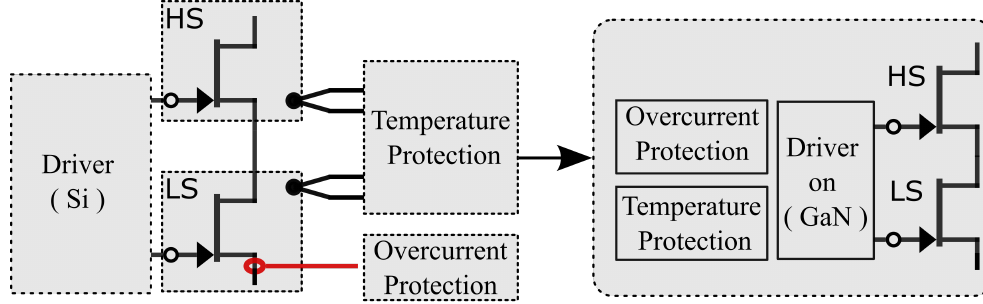
Figure 3. Illustration of monolithic integration of driver and half-bridge configuration on a single die [64,66,67].